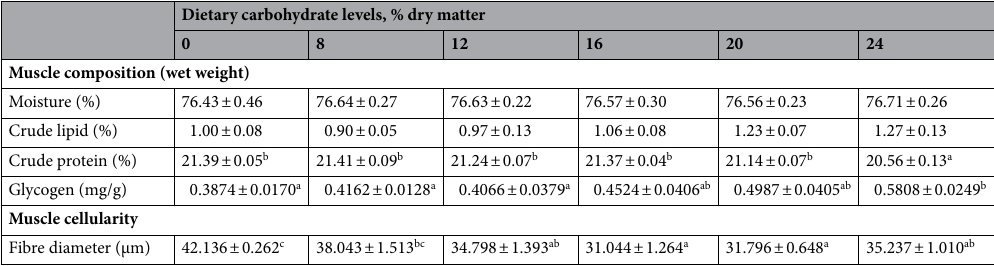
Table 3. Muscle composition and cellularity of olive flounder after a 10-week feeding trial. All data were expressed as mean ± SE. Mean values within the same row with different superscripts are significantly different ( P < 0.05; Tukey’s